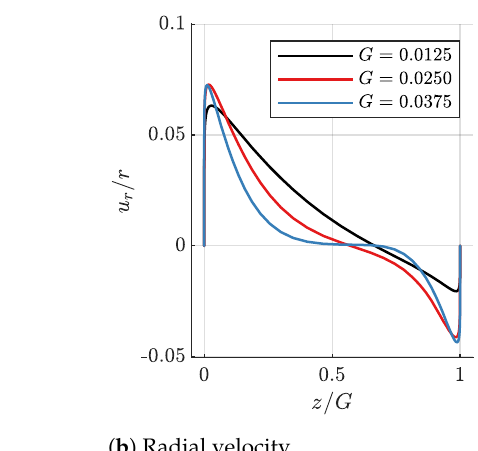
Figure 9. Axial profiles of radial and circumferential velocity components relative to the disc speed at the radius of 0.92 and at the Reynolds number of Re = 2.5 · 10 8 , through-flow mass flow rate of ˙ m = 1.1 · 10 − 3 and at different cavity widths. Simulation results.